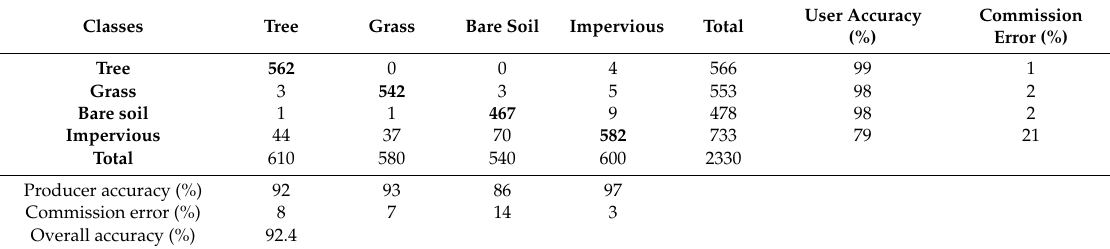
Table 7. Confusion matrix for the land cover classification of Mexico